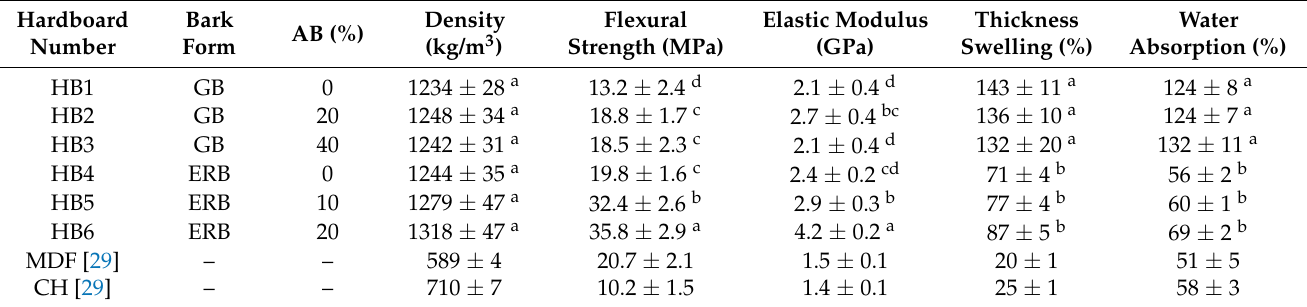
Table 8. Density, flexural properties, and water resistance of hardboards (HB) produced from ground and extrusion- refined barks (GB and ERB, respectively) through hot pressing (200 ◦ C mold temperature, 20 MPa applied pressure, and 5 min molding time) 1 , and comparison with the properties of two commercial wood-based materials (i.e., MDF and chipboard